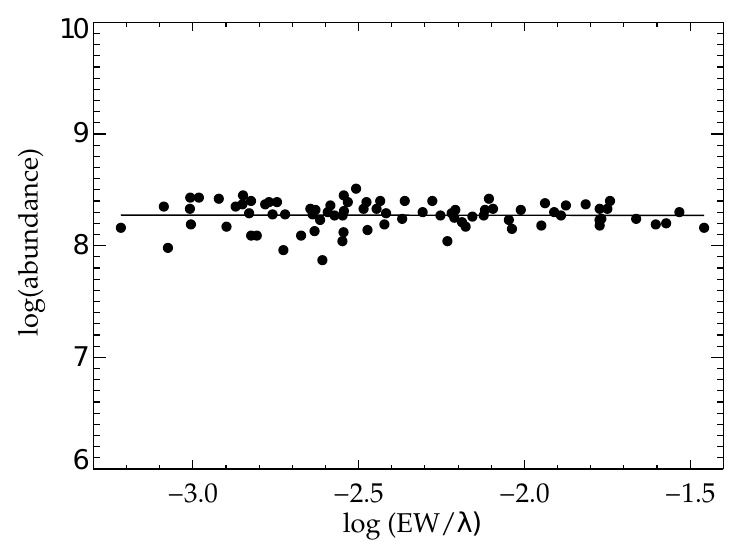
Fig. 2. The dependence of the carbon abundance on the C I line strengths. The plot is made for a microturbulent velocity of 6.8 km s − 1 .